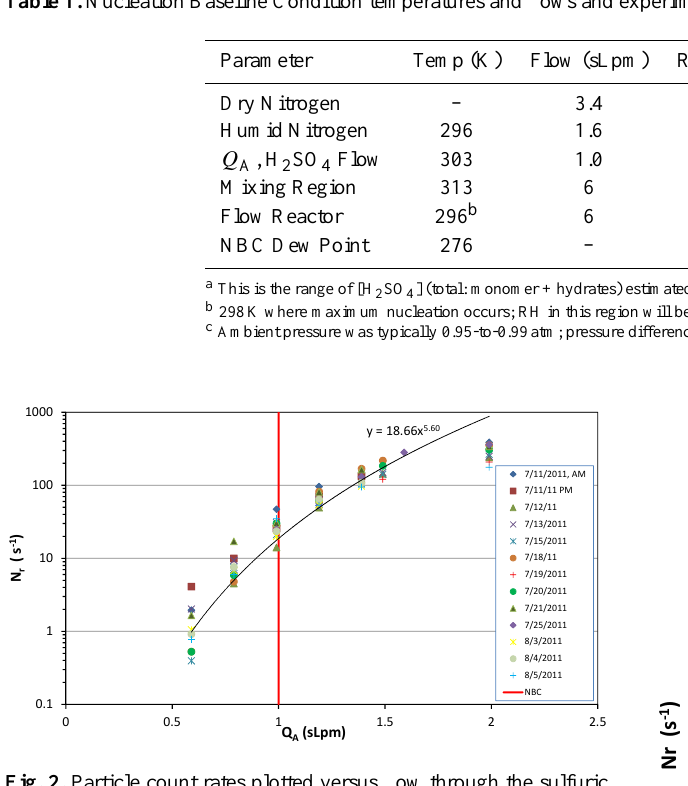
core ion count 4